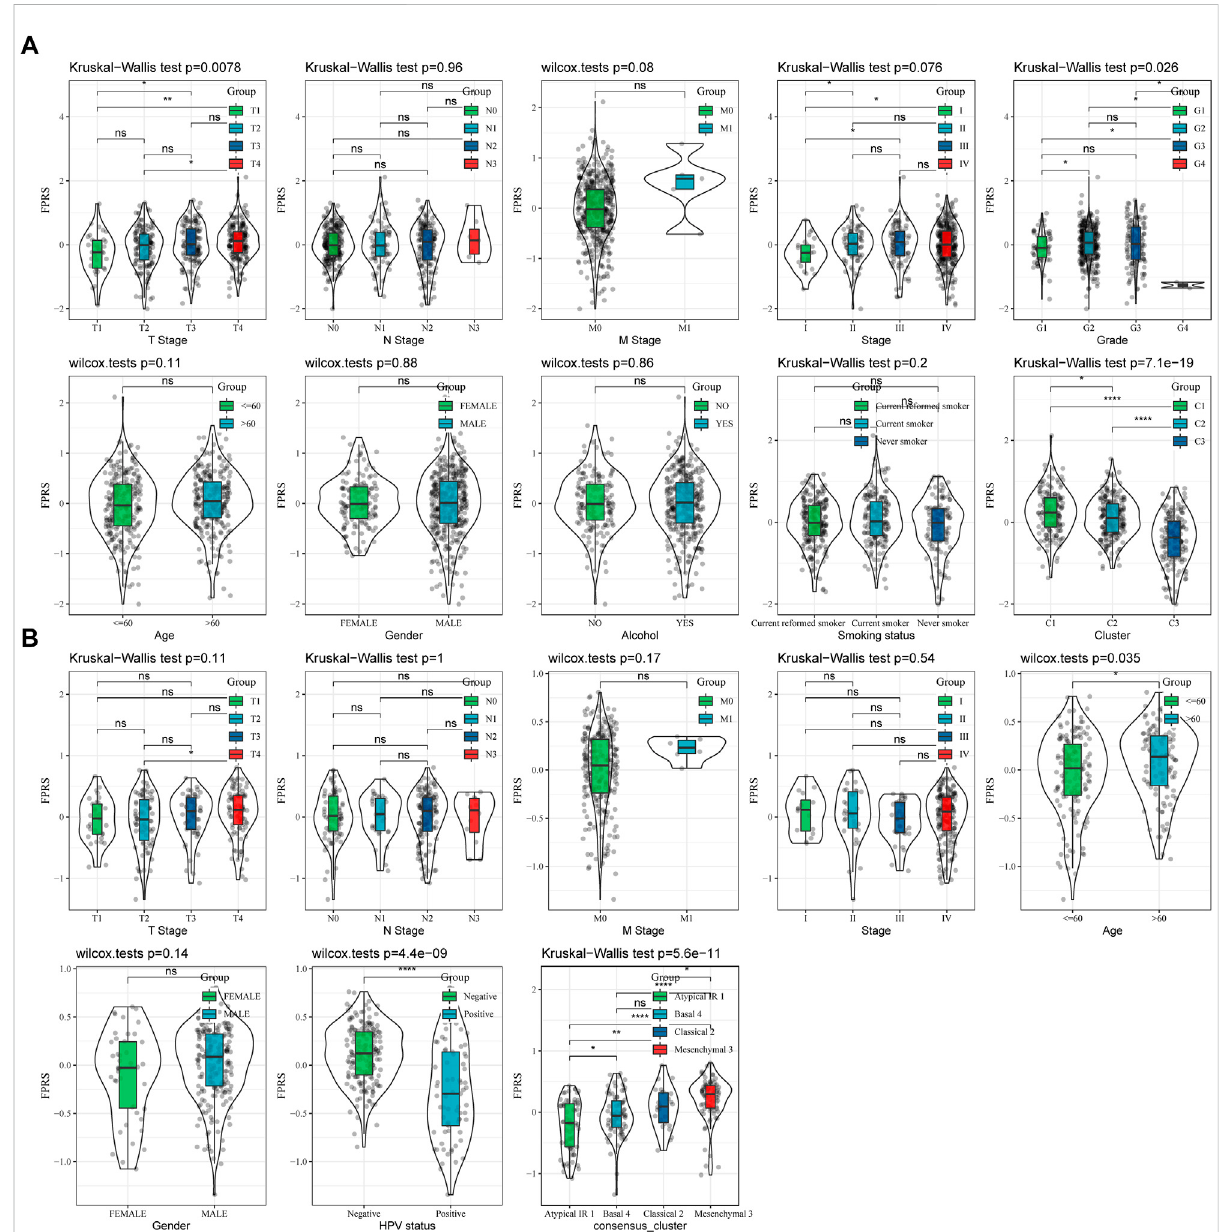
FIGURE 7 FPRS scores on different clinicopathological features and different molecular subtypes. (A) Differences in FPRS between different clinicopathological groups in TCGA-HNSC cohort; (B) Differences in FPRS between different clinicopathological groups in GSE65858